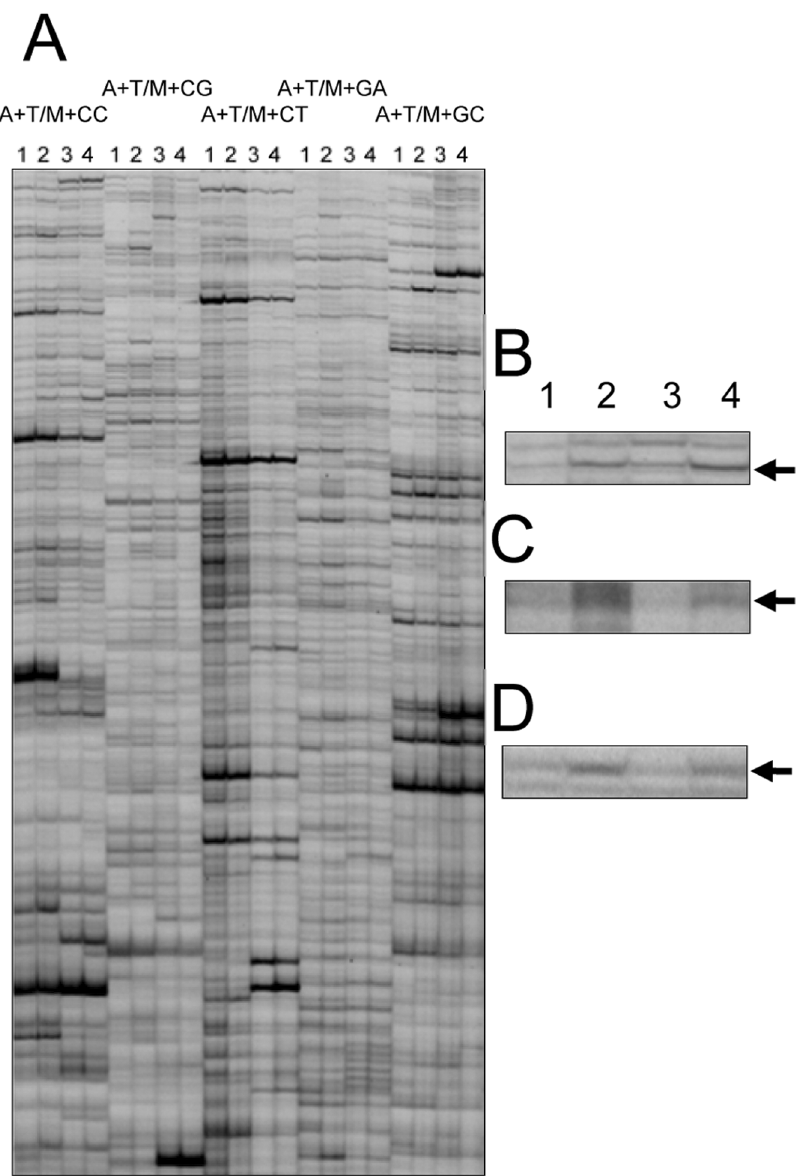
Figure 2. cDNA-amplification fragment length polymorphism patterns from M. incognita generated with A + 1/M + 2 primer combinations. A, Patterns generated with different primer combinations. B through D, selected part of gels showing differential transcript-derived fragments: B, P57E2 obtained with A + T/M + CC; C, P64A1, obtained with A + C/T + CG; and D, P66E1, obtained with A + C/T + GT. Lanes 1, 2, 3 and 4=cDNA from